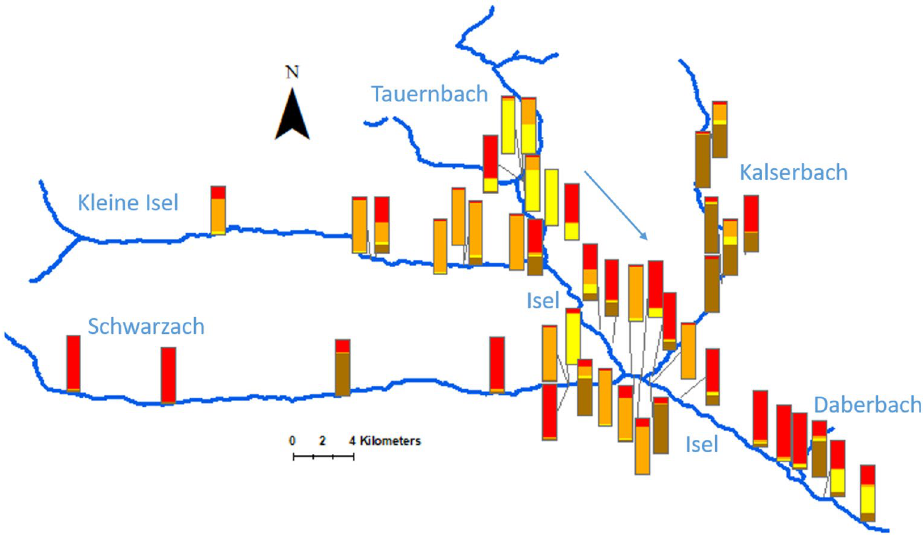
Figure 2. Genetic structure along Isel and its tributaries. For each sampled site, the percentage of genotypes assigned to each of the four groups is shown (displayed in red, orange, yellow and brown, sorted by site see Table 1). The tributaries Tauernbach (north, mainly yellow and red), Kleine Isel (north-west, mainly orange), Schwarzach (west, mainly red) and Kalsersbach (east, mainly brown) all contribute to the high diversity at Isel. The high genetic diversity in the area where Schwarzach and Kalserbach flow into Isel is subsequently lost further downstream, where a majority of genotypes is assigned to one group (red), before the inflow of Daberbach (contribution of yellow